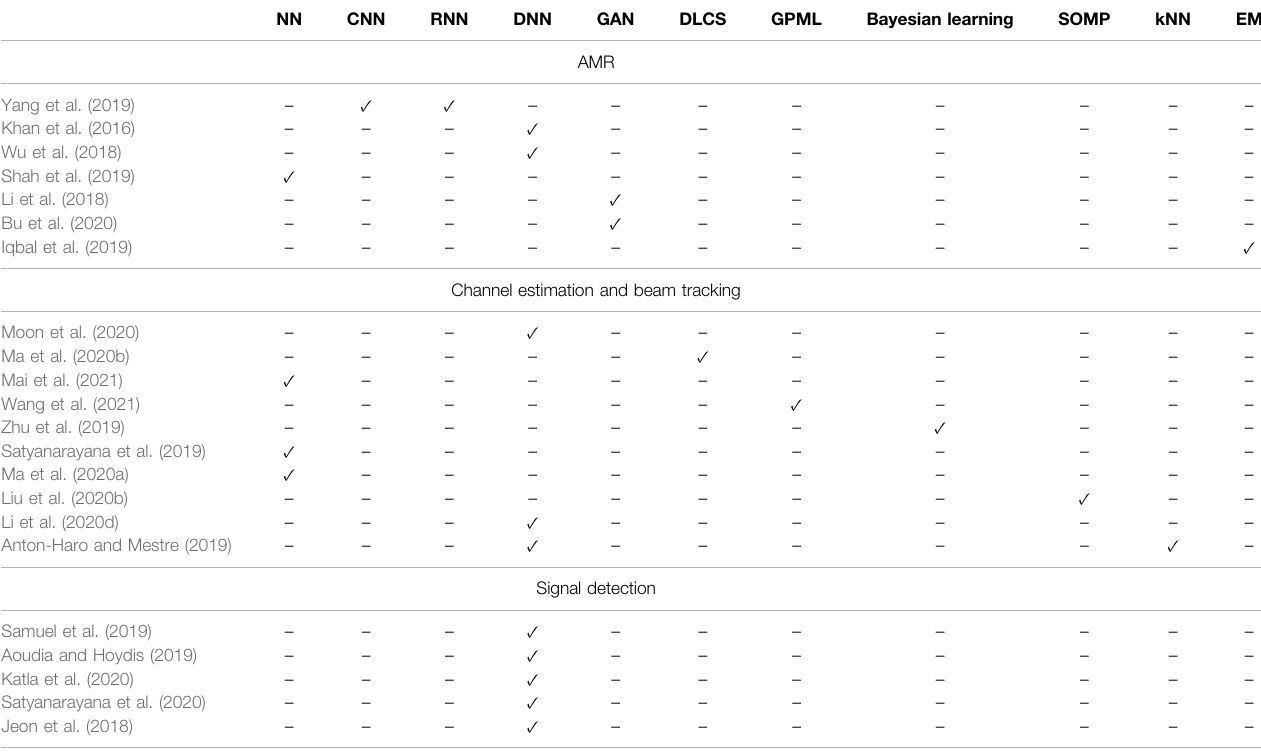
TABLE 2 | ML algorithm types applied in